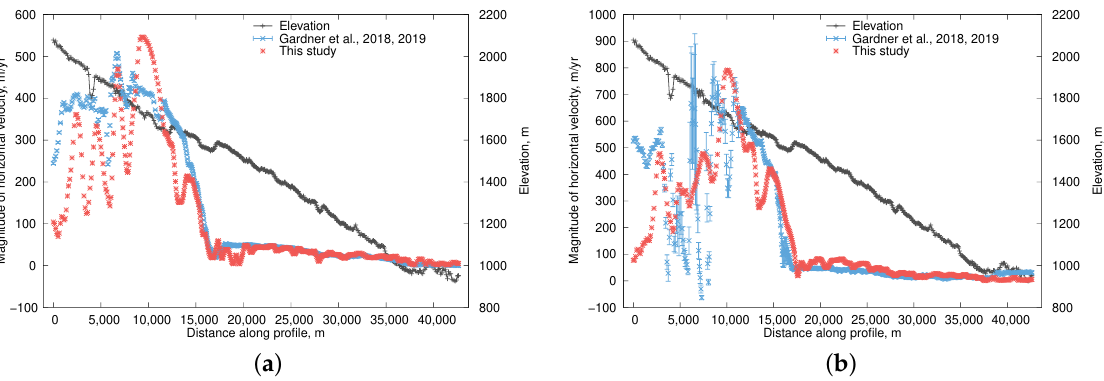
Figure 5. Comparison between SAR-derived (this study) and Landsat-derived [9,10] magnitude of mean horizontal flow velocities during year ( a ) 2017 and ( b ) 2018. For these tests only, SAR-derived flow velocity was computed as flow displacement over respectful periods divided by time interval of one year.